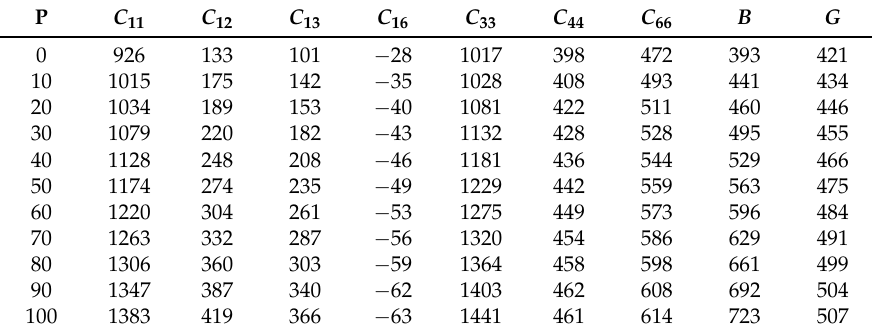
Table 2. The calculated elastic constants (in GPa) and elastic modulus (in GPa) of I4 –carbon at different pressures.